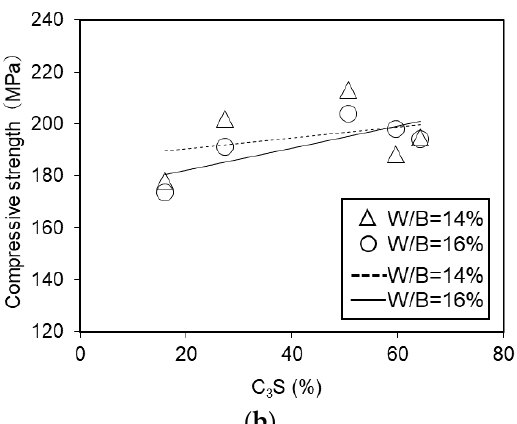
Figure 7. Relations between C 3 S content and compressive strength. ( a ) Seven days. ( b ) Twenty-eight days.